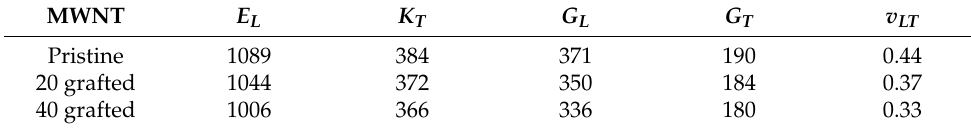
Table 3. Transversely isotropic elastic constants of MWNTs